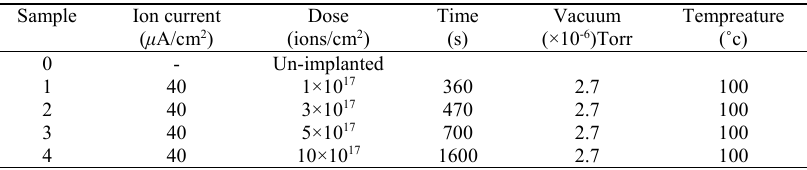
Table 1. Before starting the ion implantation, the Table 1. The process parameter during